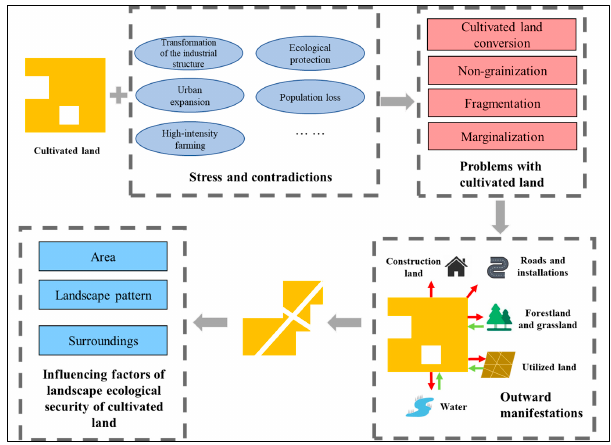
Figure 1. Cultivated landscape security Theoretical framework.